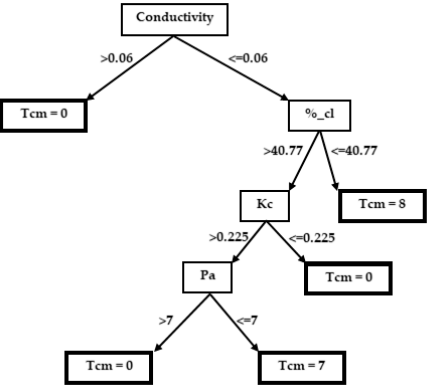
Figure 3. Decision tree for Pb = Plantago bellardii All. The numbering inside the boxes represents the abundance–dominance index converted to Van der Maarel [40]. The other numbering corre- sponds to the range of values of the edaphic attributes.